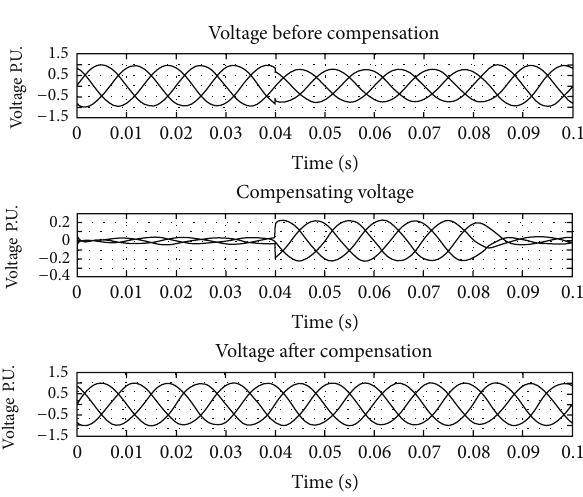
Figure 8: PCC voltage with sag, compensating voltage and voltage after compensation.